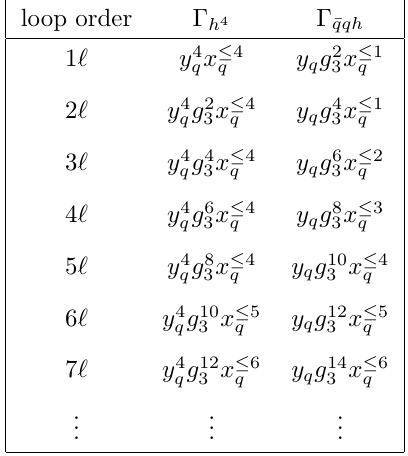
and Γ n‘ , which are not constrained to be vanishing by the theorem. ¯ qqh h 4